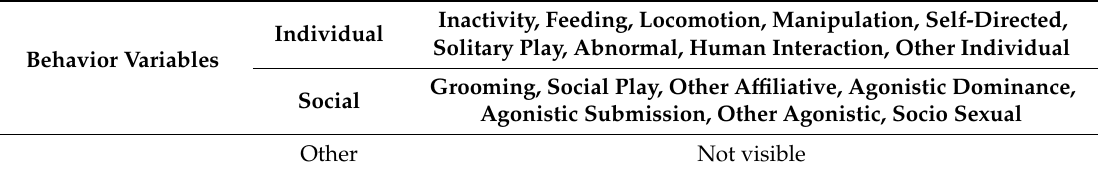
Table 3. List of behaviors recorded using two minutes instantaneous scan